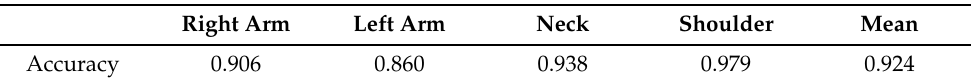
Table 5. Accuracy results for each parameter using a 2-class classifier: safe (range 0–1) and dangerous (range 2–3).